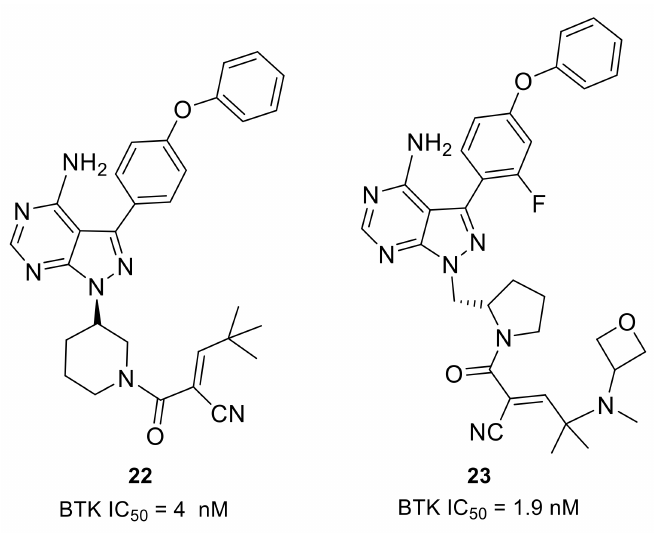
Figure 8. The representative structures of covalent reversible